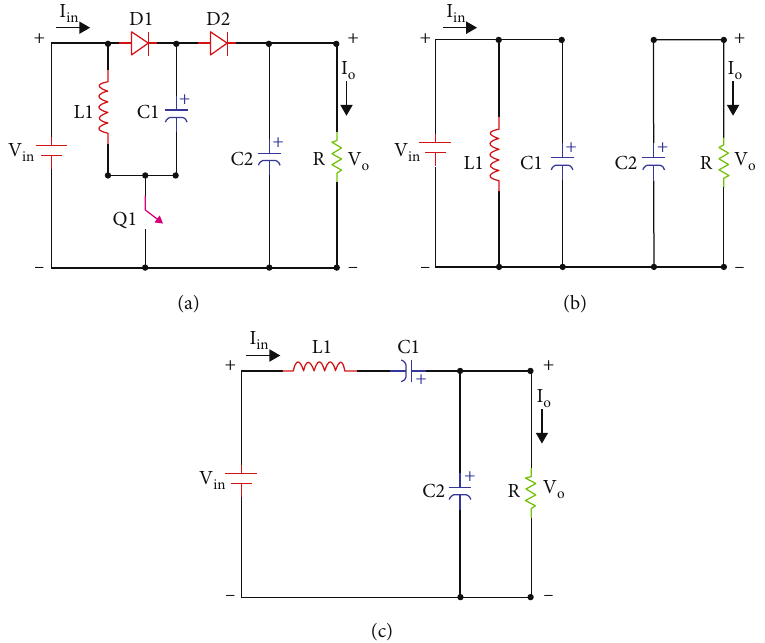
Figure 4: (a) First lift stage 3. (b) Switching mode-1 3. (c) Switching mode-2.